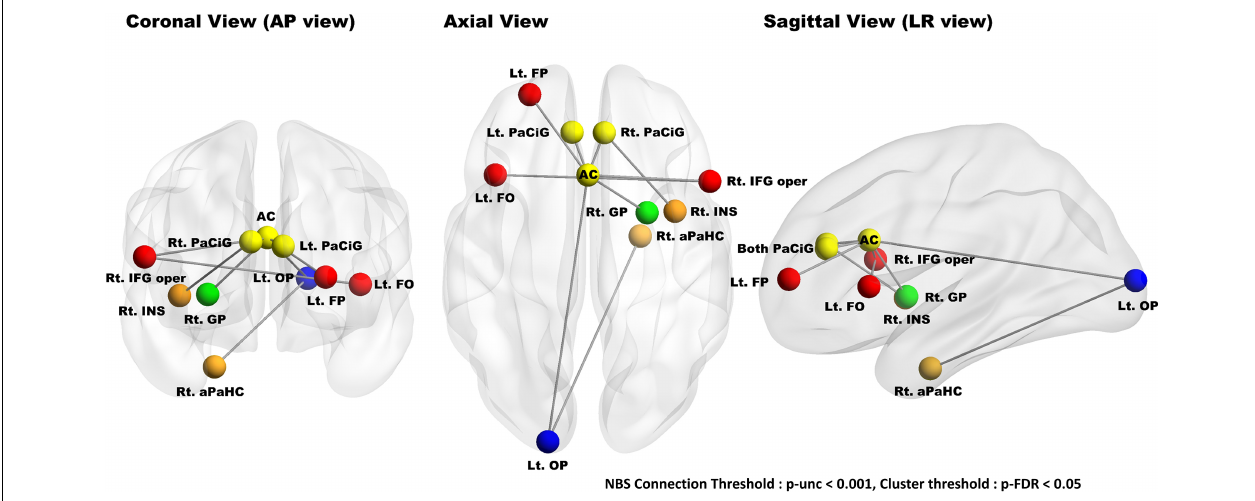
FIGURE 6 | Results of group comparisons (high nBR > low nBR) with a network-based statistical analysis. NBS analysis identified a single nBR network composed of the cingulate gyrus (anterior division), paracingulate gyri, left frontal pole, left frontal operculum cortex, left occipital pole, right pallidum, right insular cortex, left anterior parahippocampus, and right inferior frontal gyrus (pars opercularis); the connection threshold was p < 0.001 (uncorrected), while the cluster threshold was p < 0.05. The nodes located in the frontal, temporal, cingulate, basal ganglia, and occipital lobes are marked red, orange, yellow, green, and blue, respectively. NBS, network-based statistical; nBR, behavioral reserve for negative symptoms; Lt., left; Rt., right; FP, frontal pole; FO, frontal operculum cortex; PaCiG, paracingulate gyrus; AC, cingulate gyrus, anterior division; GP, globus pallidus; IFG oper, inferior frontal gyrus pars opercularis; INS, insular cortex; aPaHC, parahippocampal gyrus; OP, occipital